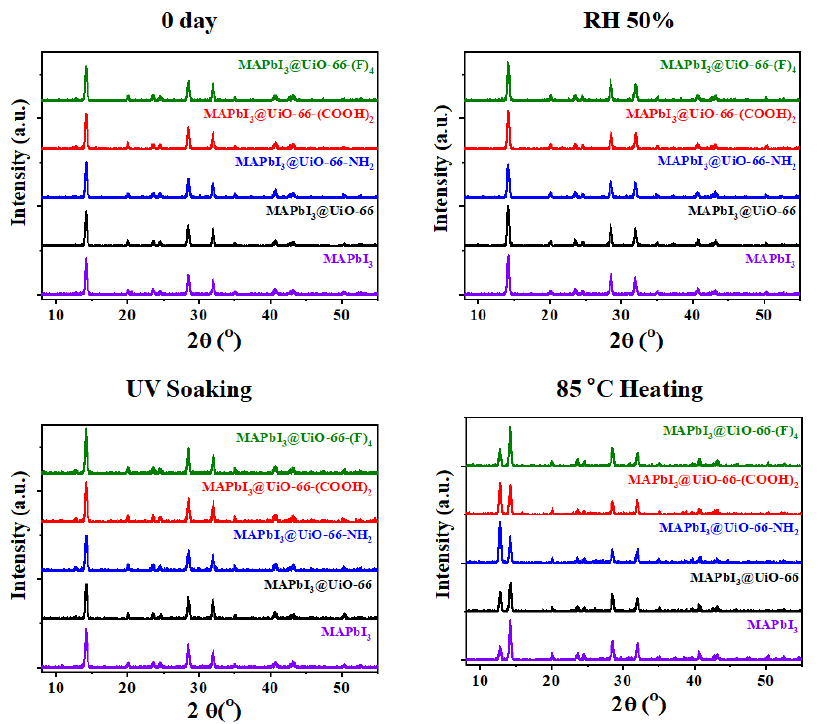
Figure 4. The XRD spectra of the pristine MAPbI 3 and MAPbI 3 @UiO-66 nanocomposite samples before and after humidity, UV-light, and heat aging for two weeks.